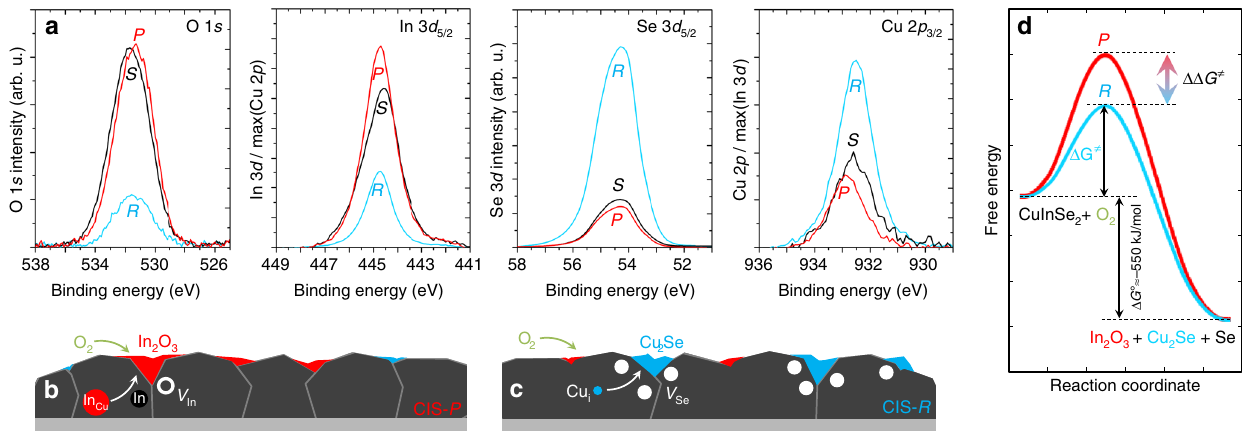
Fig. 4 Composition-dependent CuInSe 2 surface reactivity against O 2 at room temperature. a XPS surface analysis of Cu-poor CIS (P, red), stoichiometric CIS (S, black) and Cu-rich CIS (R, cyan) fi lms after removal of Cu-Se phases by KCN (bold)etching and subsequent exposure to air at room temperature for 24 h. Schematics representation of point defect oxidation reactions in CIS-P ( b ) and CIS-R ( c ) drawn to match the XPS results, i.e., larger share of In-O outgrowth in Cu-poor material and of Cu-Se in Cu-rich material. d Diagram of free energy vs. reaction coordinate for the oxidation of CuInSe 2 to In 2 O 3 , Cu 2 Se and Se showing the spontaneous (negative) bulk Gibbs free energy of reaction at room temperature ( Δ G °), and the proposed occurrence of different Gibbs free activation energies ( Δ G ≠ ) for the oxidation pathways under Cu-poor and Cu-rich CIS